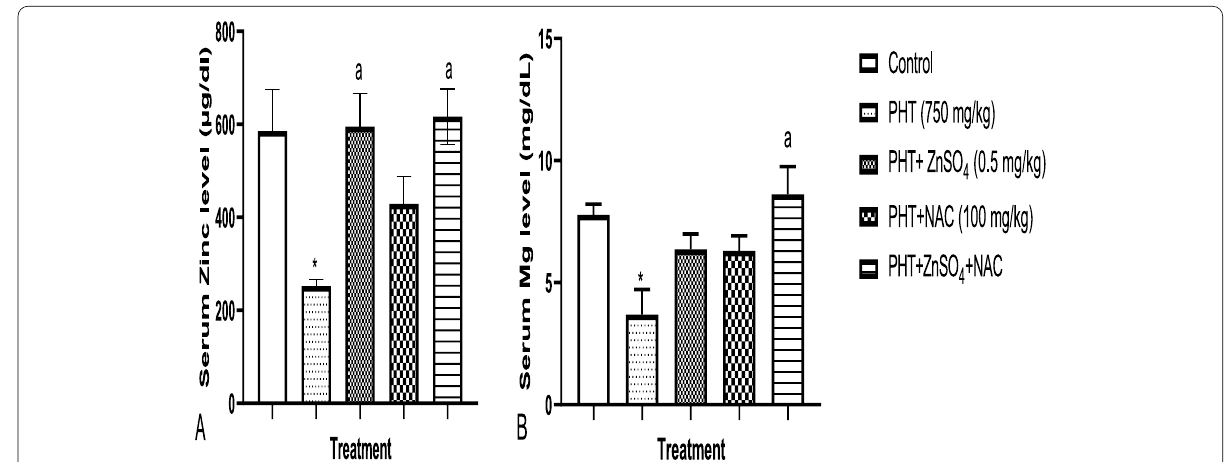
Fig. 5 Effect of co‑administration of zinc sulfate and N‑acetylcysteine on serum zinc ( A ) and Mg ( B ) levels in phthalate‑treated male Wistar rats. Values are expressed as mean SEM ( n 5) (one‑way ANOVA followed by Tukey’s post hoc test). PHT phthalate, ZnSO 4 zinc sulfate, NAC ± = N‑acetylcysteine. ⁕ and a p < 0.05 considered statistically significant when compared with the control and PHT‑treated groups